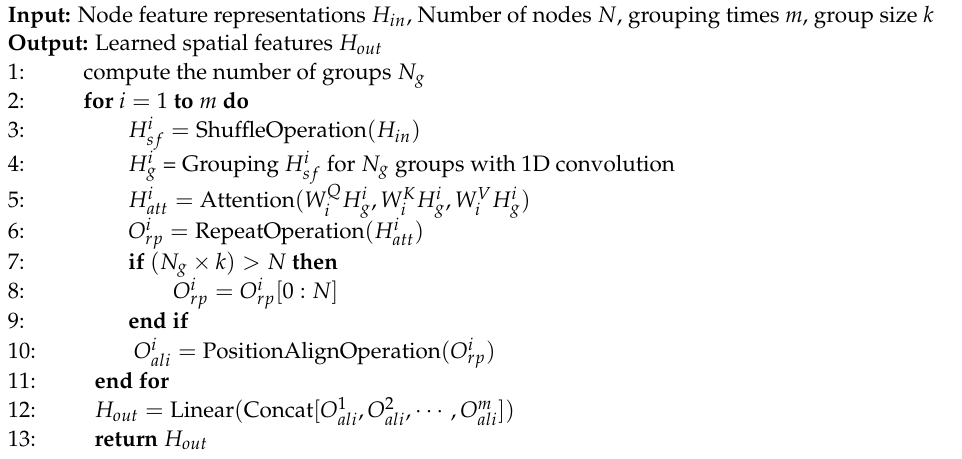
Algorithm 1: Group-Range Convolutional Attention